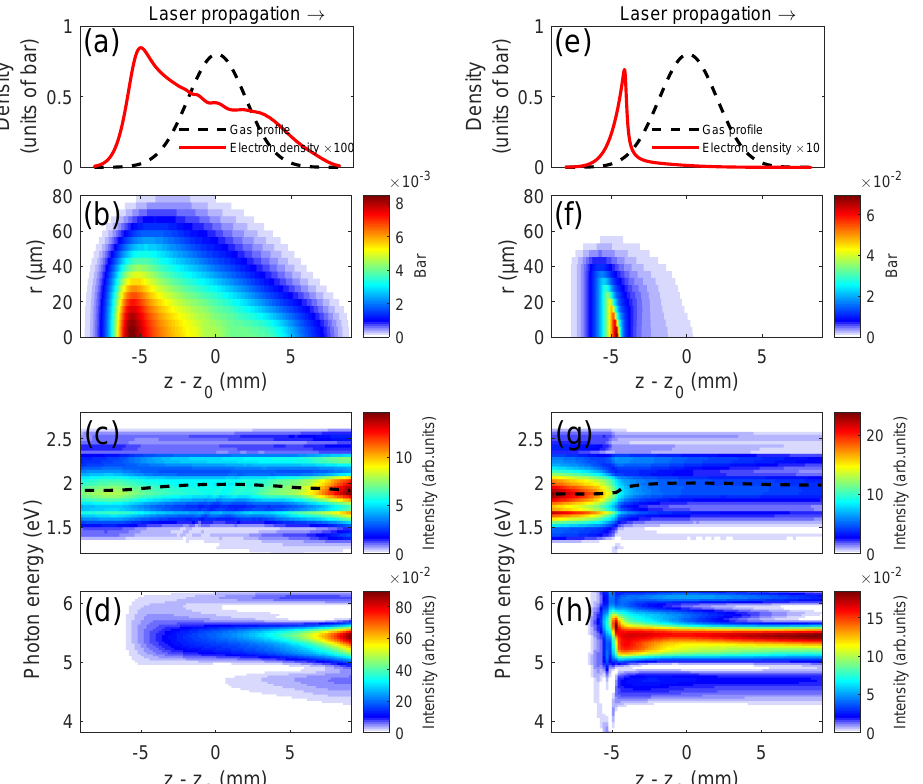
Figure 6. Simulated nonlinear DUV generation dynamics in Ar. The left column ( a – d ) and the right column ( e – h ) panels are the results for the two different cell positions: z 0 = − 14 mm and +14 mm, respectively. ( a , e ) shows the z -dependent on-axis ( r = 0) electron densities after the laser has passed. ( b , f ) are the two-dimensional ( r and z ) electron density profiles. The spectra of propagating fundamental ( c , g ) and the third-order harmonic ( d , h ) were taken from the on-axis ( r = 0). In ( c , g ), the mean photon energies of the fundamental laser are indicated by the dashed lines to visualize the